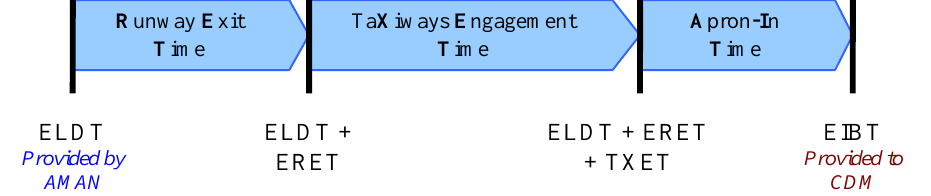
Figure 1. Reference Estimated Taxi in Time (EXIT) breakdown. ELDT, Estimated Landing Time; AMAN, Arrival Manager; ERET, Estimated Runway Exit Time; TXET, Target Taxiways Engagement Time; EIBT, Estimated In-Block Time.